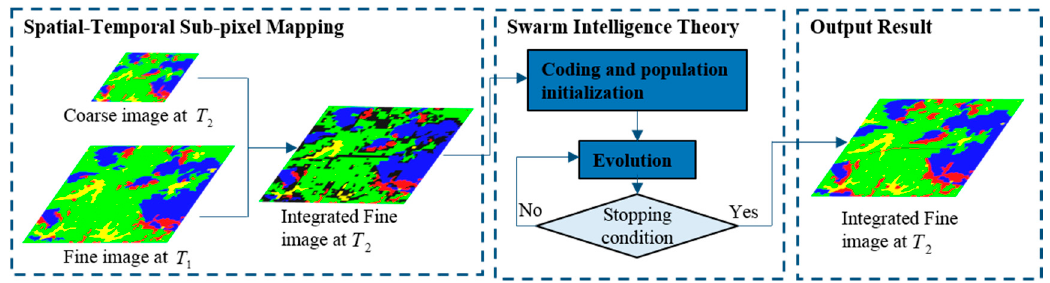
Figure 5. The framework of spatial-temporal sub-pixel mapping based on swarm intelligence theory.